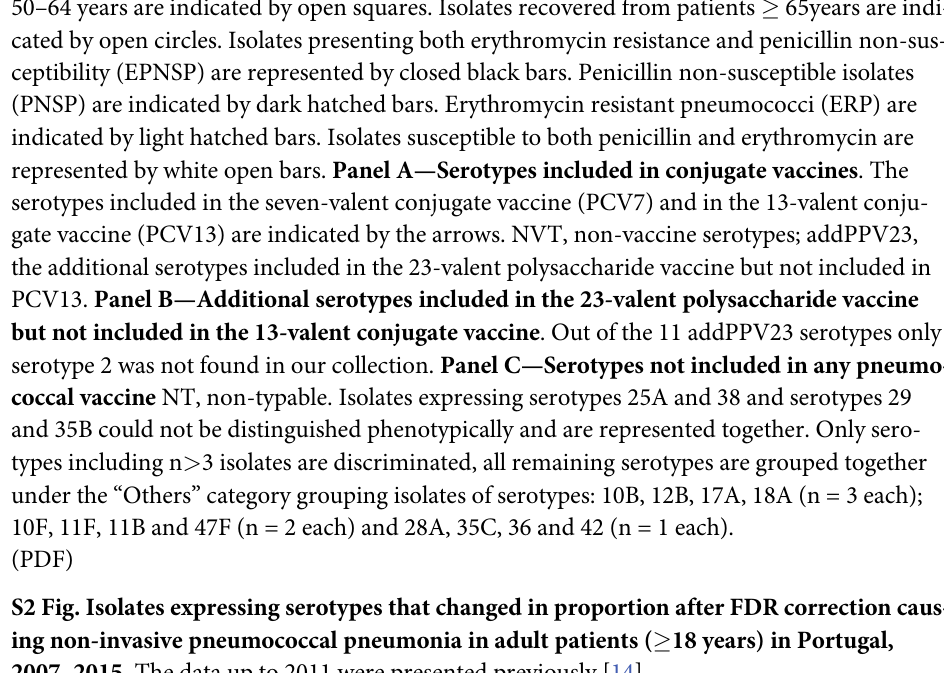
S1 Table. Serotypes of the isolates responsible for non-invasive pneumococcal pneumonia in adult patients ( � 18 years), 2007–2011. These data were presented previously [14]. S2 Table. Serotype distribution of the isolates causing non-invasive pneumococcal pneu- monia and invasive pneumococcal disease in adults in Portugal